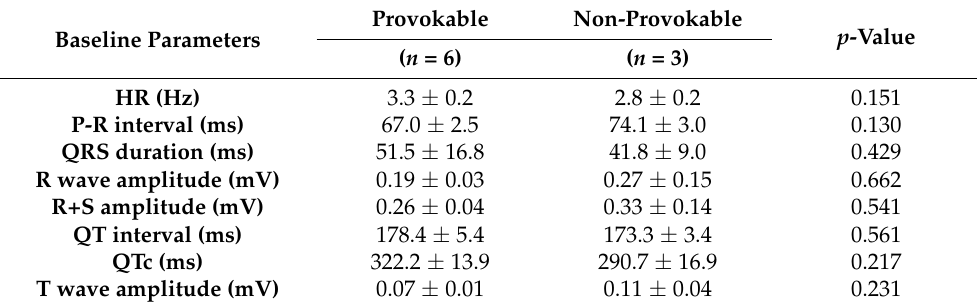
Table 2. Baseline ECG parameters in male rabbits with and without provokable Brugada-pattern ECG